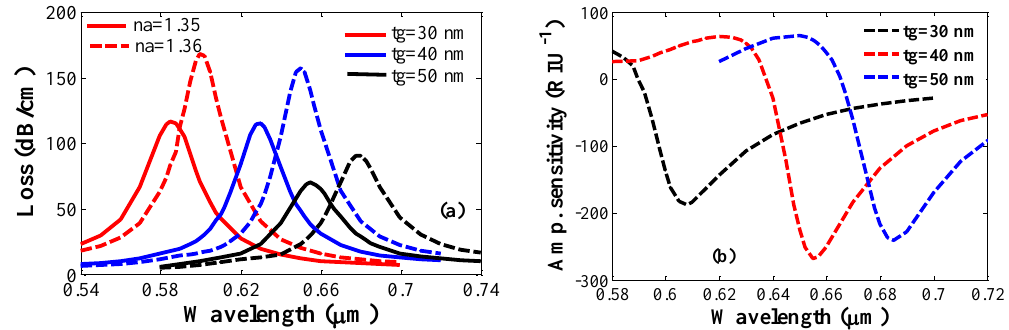
Figure 4. ( a ) Fundamental loss variation of the proposed sensor for different gold layer thicknesses and ( b ) amplitude sensitivity for different gold layer thicknesses with Λ = 2 μm, d c = d 1 = 0.2Λ, and d = 0.4Λ for an analyte RI of 1.35.